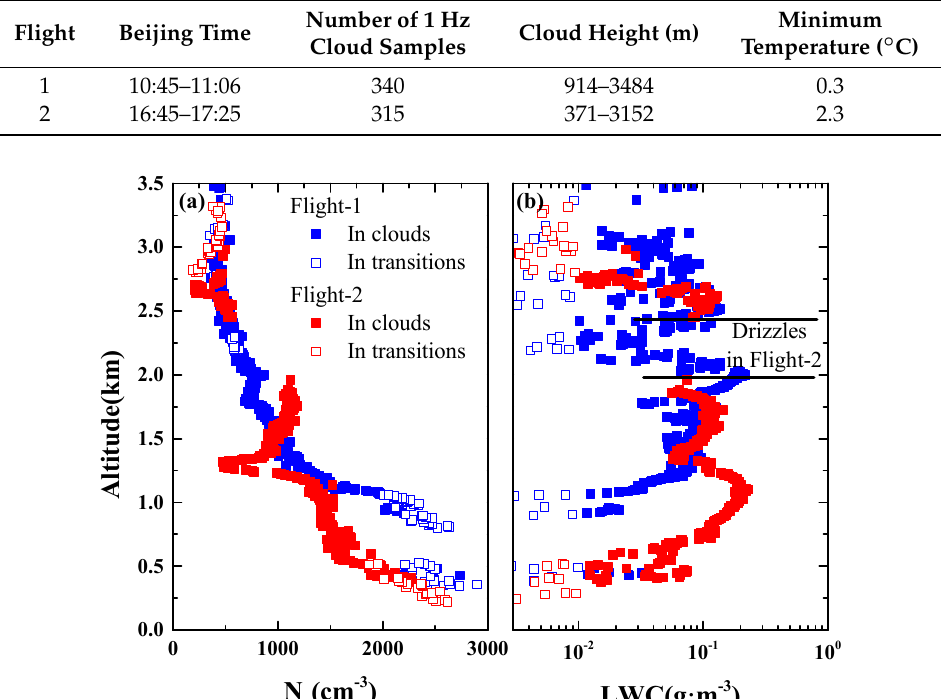
Figure 1. Vertical profiles of aerosol concentration ( N a ) and liquid water content (LWC) in the two flights, corresponding to Figure 1( a ) and ( b ), respectively.